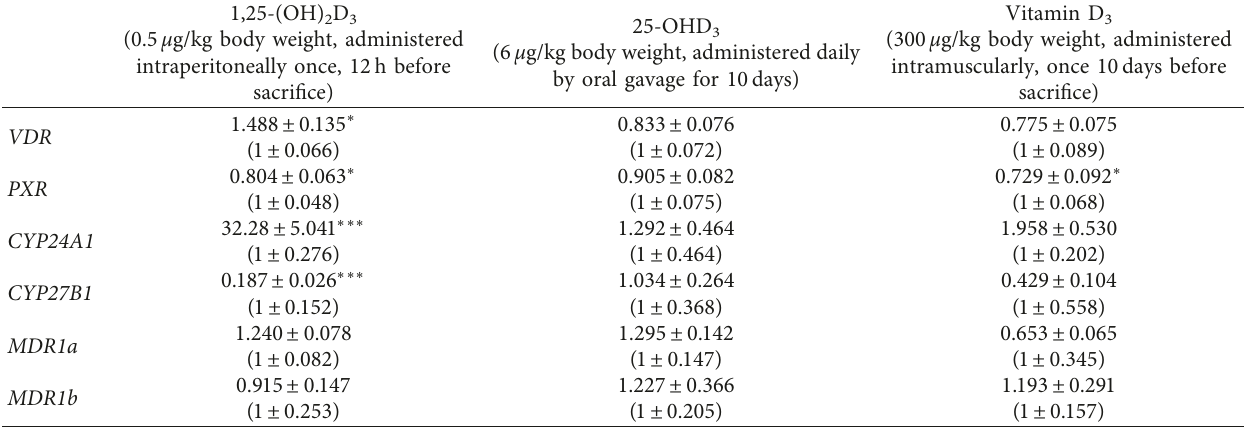
Table 5: RNA expression in the kidney of rats treated with different vitamin D metabolites normalized to